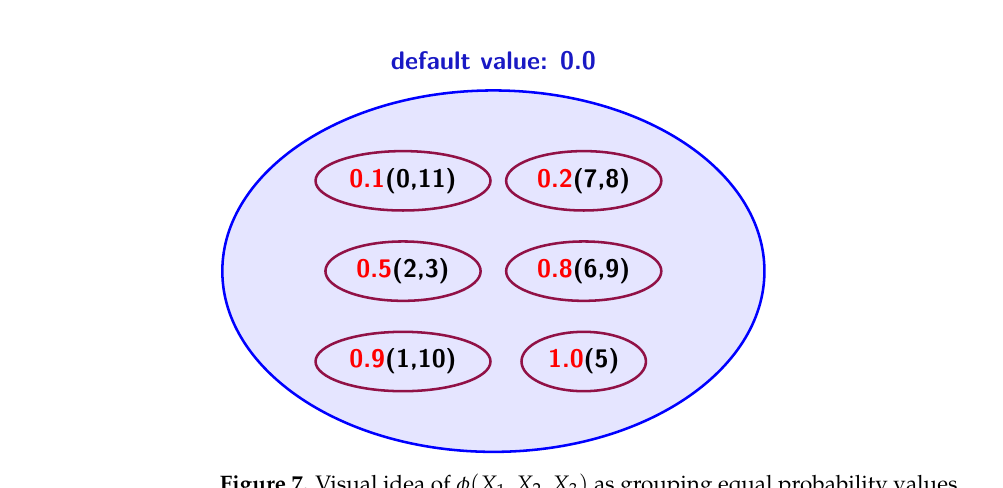
Figure 7. Visual idea of φ ( X 1 , X 2 , X 3 ) as grouping equal probability values.